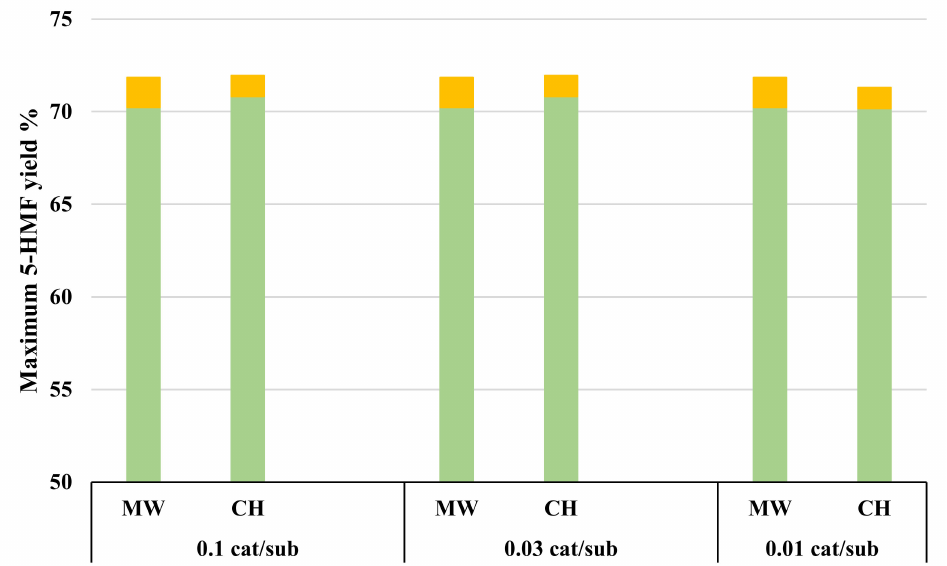
Figure 8. The effect of catalyst-to-substrate ratio on simulated maximum yields using MW heating for 10 min and CH for 90 min. The parameter estimates in the model correspond to the following conditions: 3 mL DMSO/acetone medium (70:30 w / w ) and 10 mg MIL-101(Cr)-SO 3 H(3) at 160 ◦ C. ( (cid:4) ) 5-HMF (mmol), ( (cid:4) ) FA + LA